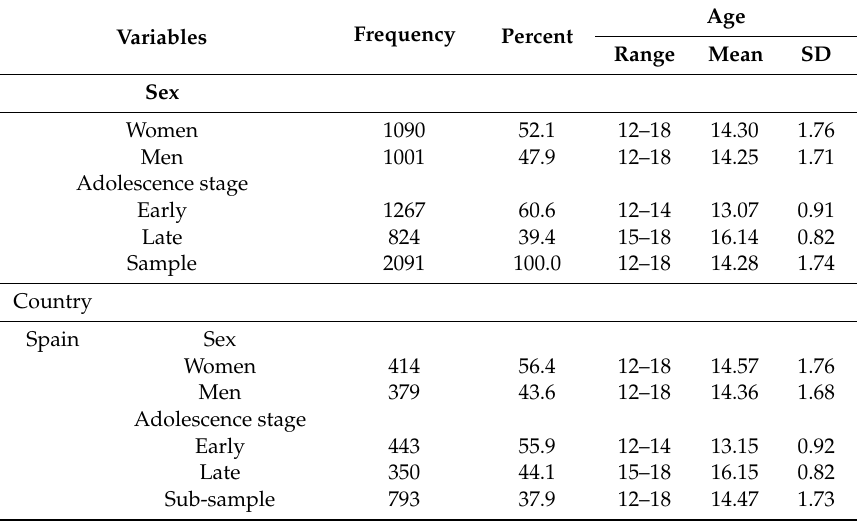
Table 1. Distribution of sample by sex, adolescent stage and